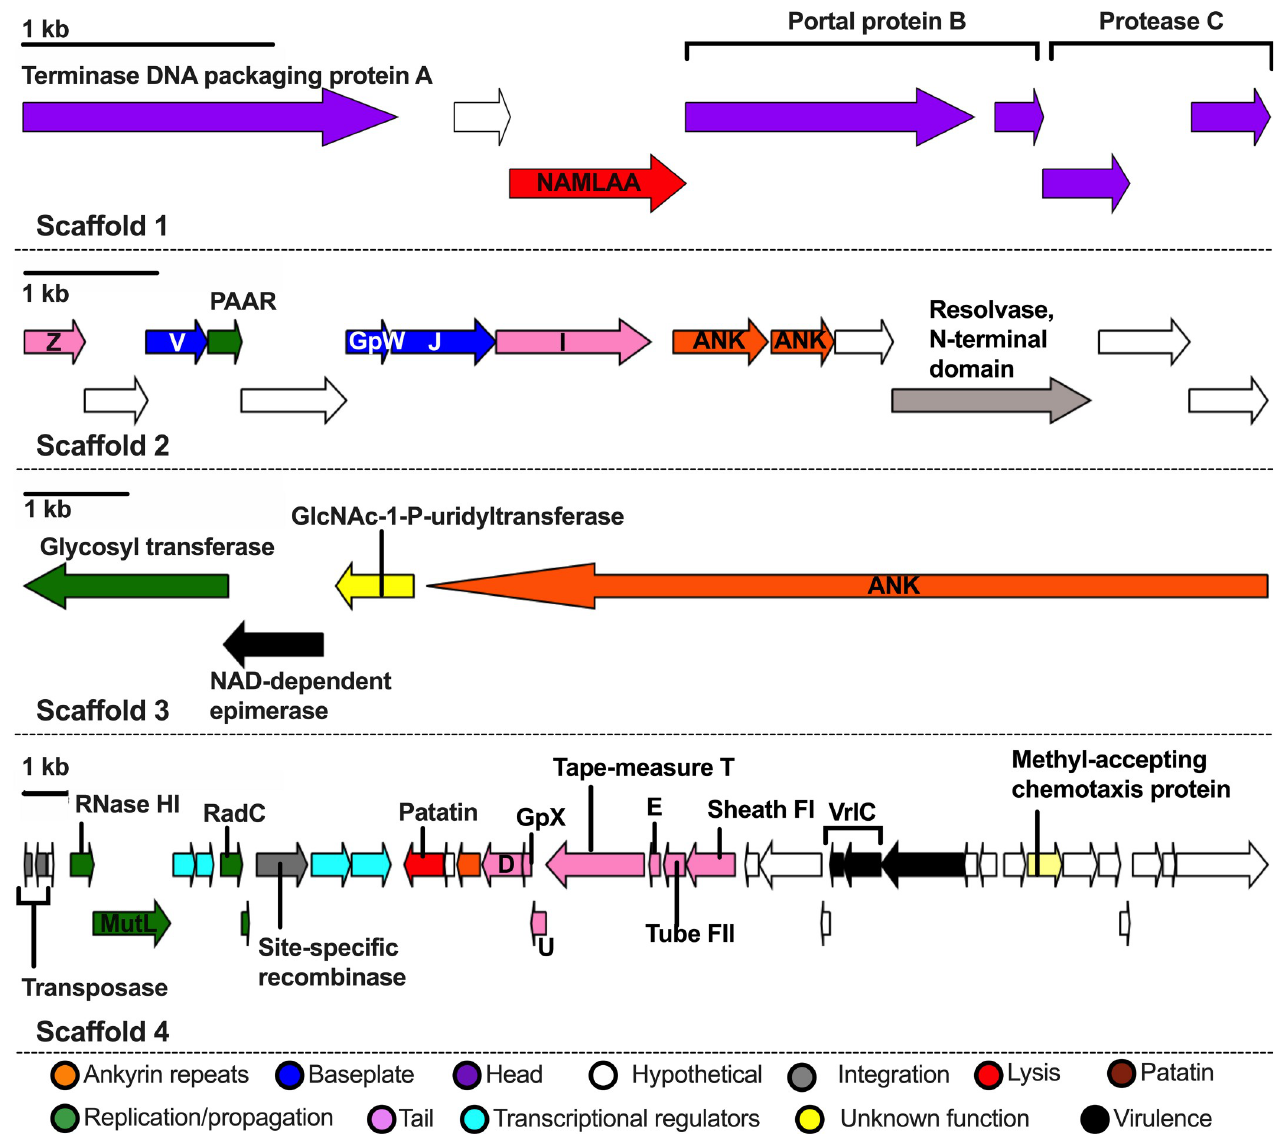
Fig 3. Annotation of the WOSoc genome. 63 features from the RASTk annotation of the 4-scaffold WOSoc assembly are displayed: ankyrin repeats (N = 4), baseplate assembly (N = 3), phage head (N = 5), integration into Wolbachia ’s genome (N = 4), lysis of Wolbachia cells (N = 2), propagation (DNA replication and mismatch repair, injection machinery, protection from host endonucleases) (N = 6), tail formation (N = 9), transcriptional regulation (N = 4), virulence (N = 4), function in phage undescribed (N = 2), hypothetical proteins (N = 20). Abbreviations: NAMLAA = N-acetylmuramoyl-L-alanine amidase; ANK = ankyrin. Scale bars: 1 kb within their respective